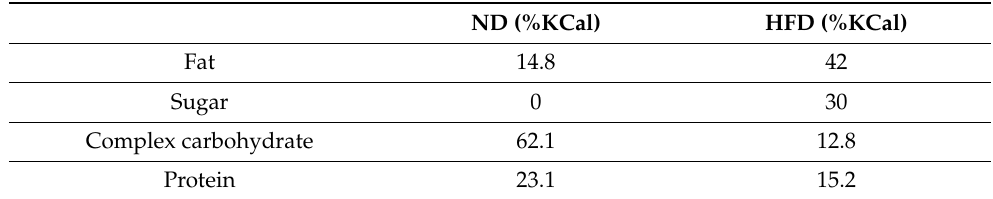
Table 1. Nutritional composition of the ND and HFD used in the study.